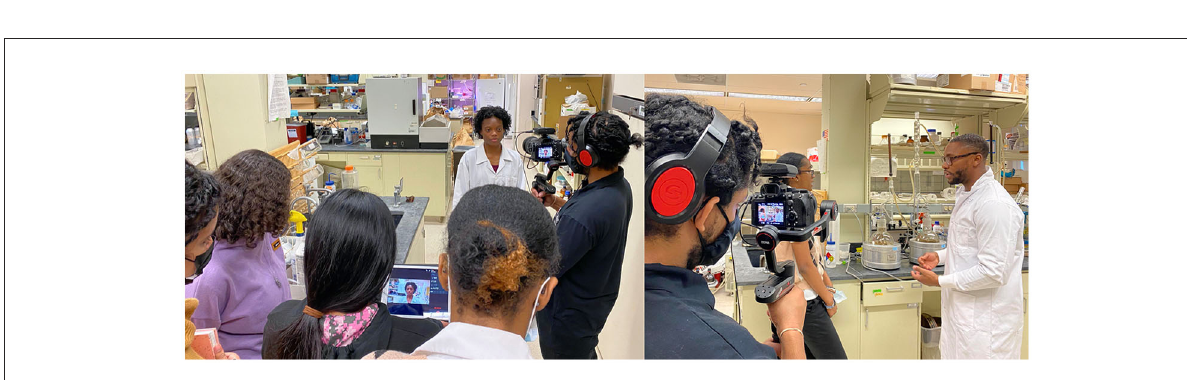
FIGURE9 High school students interview plant biologists for FAME pilot